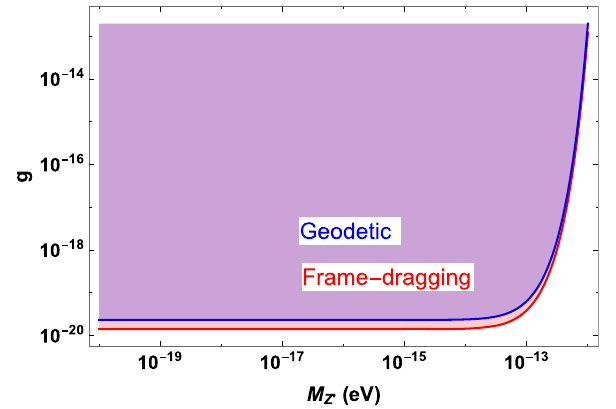
Fig. 5 Variation of g with M Z (cid:2) for L e − L μ,τ vector gauge boson mediation from the geodetic (blue) and the frame-dragging (red) mea- surements using GP-B result. The shaded regions above these lines are excluded μ × (cid:19) =